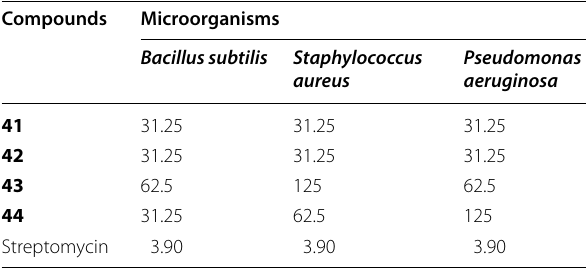
Table 13 MIC (μg/ml) values for the screened thiazolidin- ediones compounds